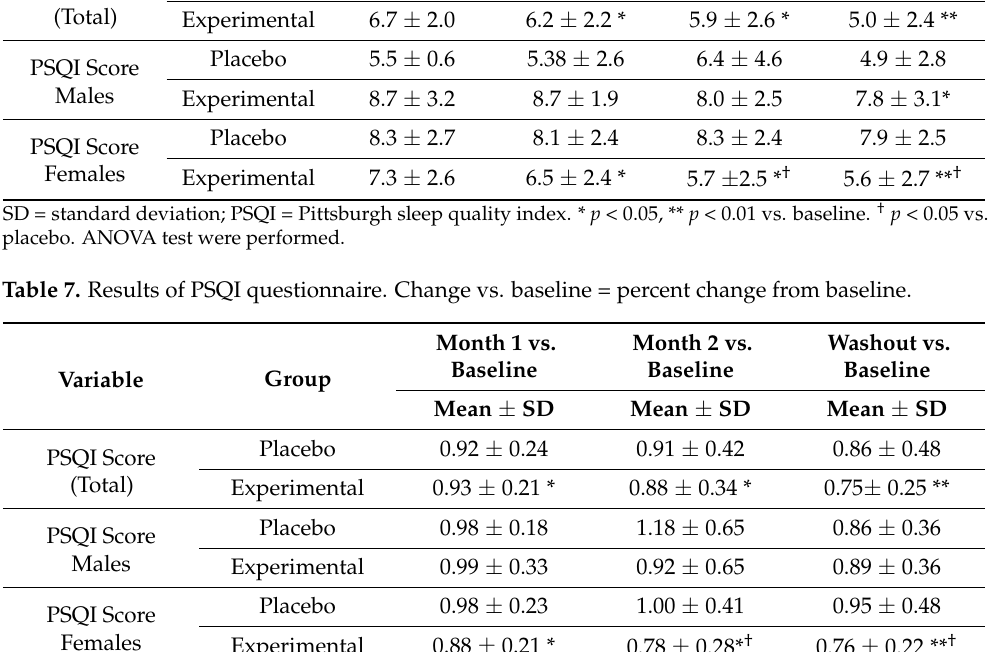
Table 6. Chart depicting values. Variable Group